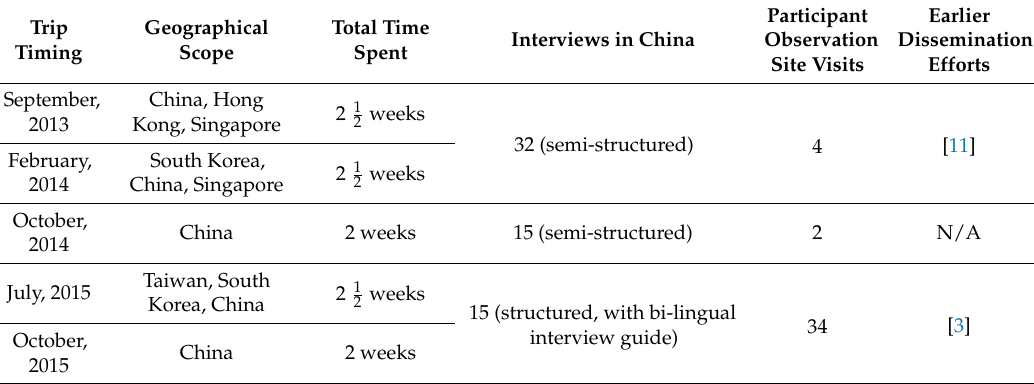
Table 2. Trips to Asia and China as part of the primary empirical data collection efforts of this research. Trip